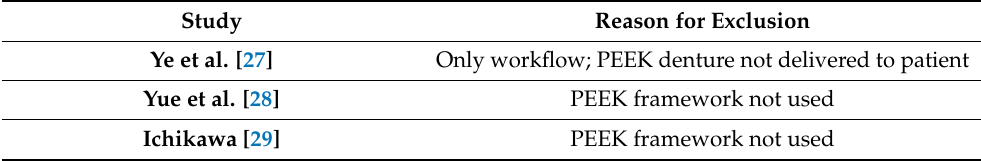
Table 1. A list of the full texts excluded along with reasons for